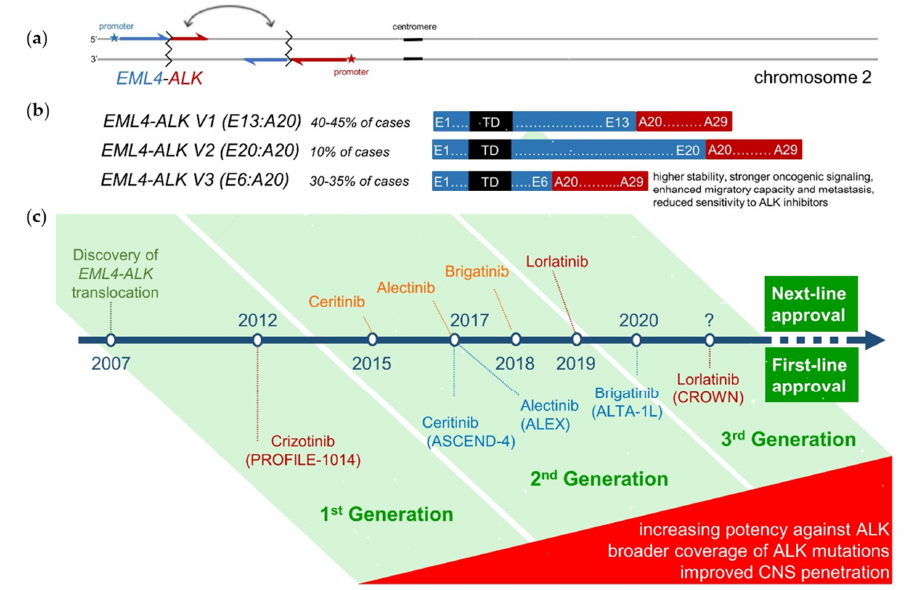
Figure 1. ( a ) Molecular pathogenesis of ALK + NSCLC: In approximately 90% of cases, a paracentric inversion in the short arm of chromosome 2 [inv(2)(p21p23)] creates the fusion oncogene EML4-ALK , which facilitates overexpression of the ALK exons 20–29 under the influence of the EML4 promoter, and their autophosphorylation due to the trimerization domain (TD) of EML4 [6]. In the remaining 10% of cases, a different partner gene is fused with ALK and triggers similar pathophysiologic effects. ( b ) The length of the EML4 component can differ between patients, with 90% harboring EML4-ALK fusion variant 1, 2 or 3. Shorter variants (mainly variant 3, aka V3, E6:A20, present in 30–35% of cases) have higher stability, accumulate more and interact better with the cytoskeleton, causing stronger oncogenic signaling, reduced sensitivity to ALK inhibitors, enhanced migration and metastasis [20–24]. ( c ) Approval timeline of currently available ALK inhibitors, along with their respective first-line phase 3 trials. Next-generation ALK inhibitors show higher potency against the native ALK oncoprotein, broader coverage against ALK resistance mutations, and improved CNS penetration